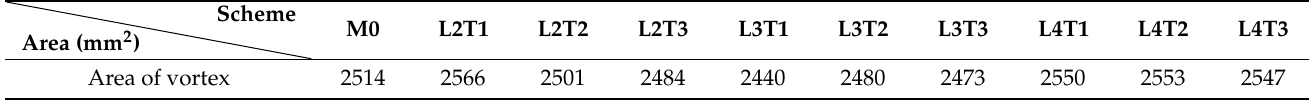
Table 3. Area of vortex for different